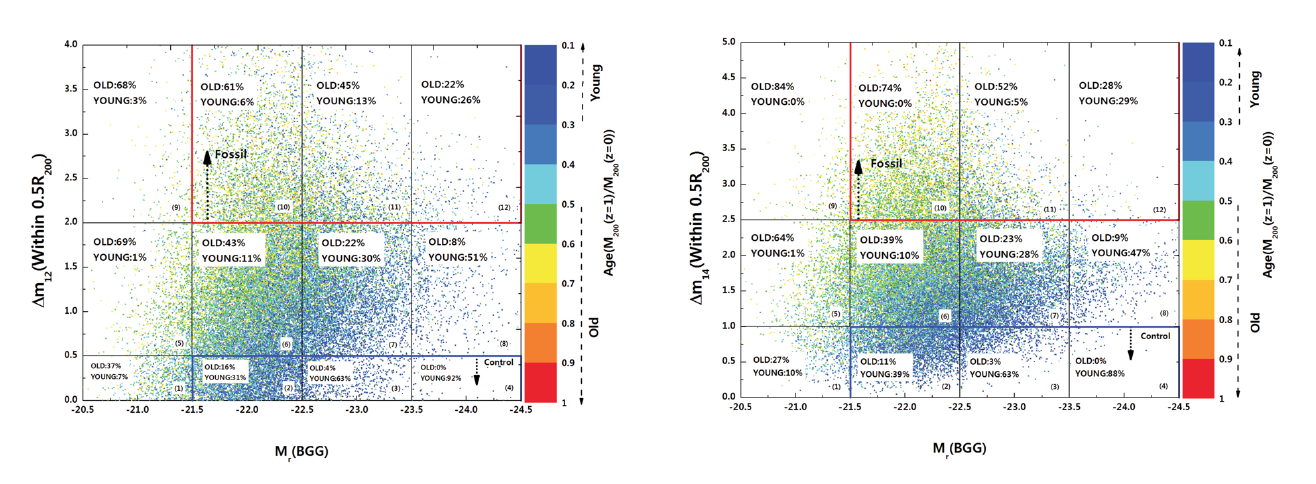
Figure 2. Distribution of the galaxy groups in the plane of luminosity gap ∆ m 12 ( left panel ) and ∆ m 14 ( right panel ) within 0.5 r 200 and the r − band magnitude of the brightest group galaxy, in the Millennium simulations with Guo et al. (2011) semi-analytic model. Data points are colour-coded according to the ratio of the group halo mass at redshift z ∼ 1 to its mass at z = 0. The plane has been sub-divided into blocks within which the probability that the halo is old or young is given. In this diagram, panels (5), (9), and (10) contain mostly old systems while the panels (3), (4), and (8) are mostly occupied by young systems. The image is taken from Raouf et al. [32]; in particular, it corresponds to their Figure